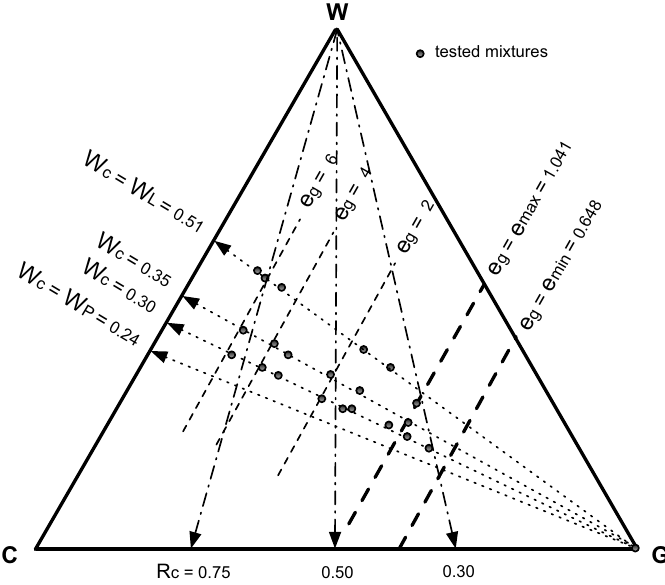
Fig. 2 – Possible morphology of saturated sand-clay mixtures.